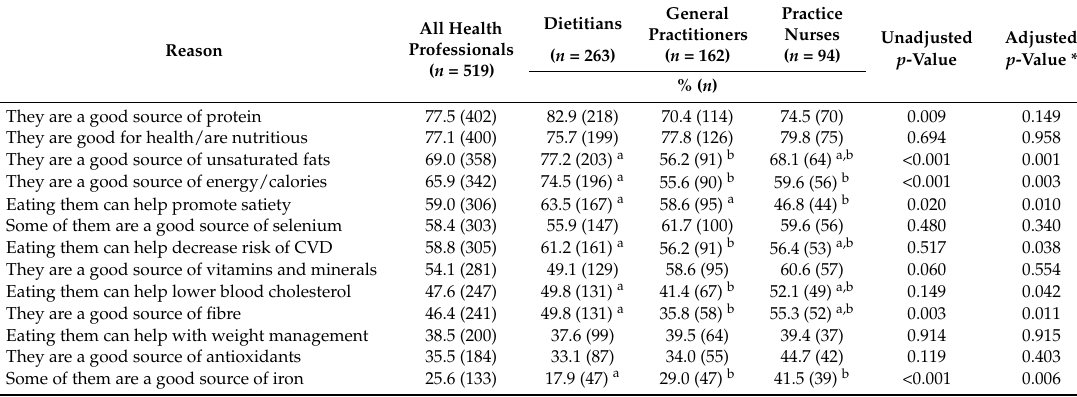
Table 4. Reasons for advising patients to eat more nuts and nut butters among health professionals who promote nut